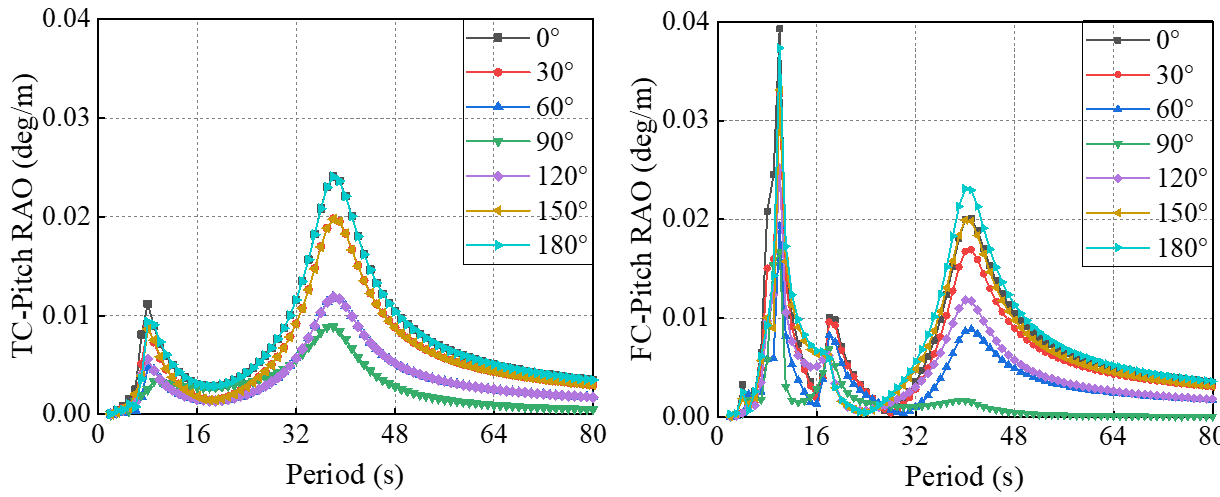
Figure 10. Pitch RAOs of SFOWTs.